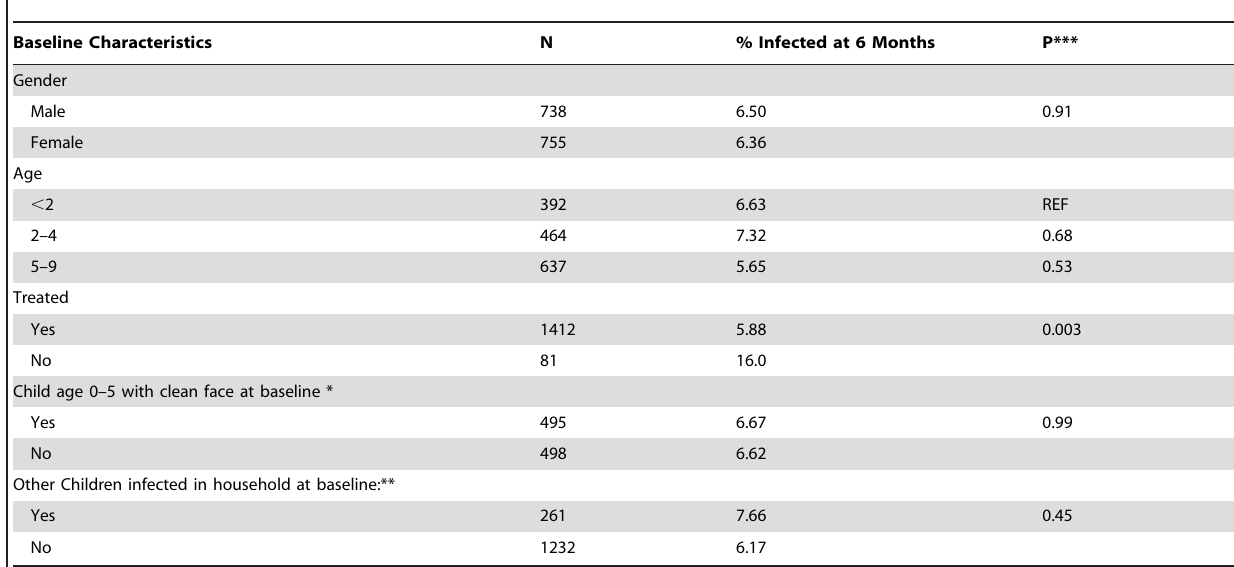
Table 4. Baseline characteristics of the sub group of 1439 children who were not infected at baseline, and infected at 6 months